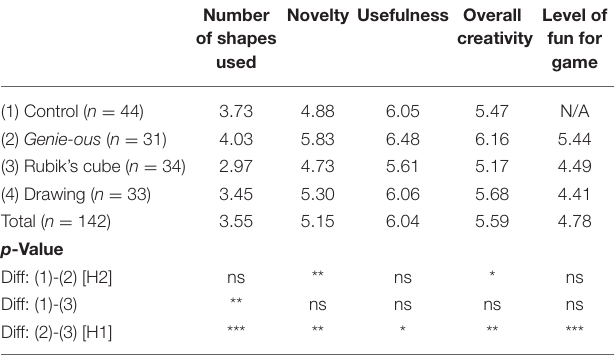
TABLE 1 | Summary of experiment 1.